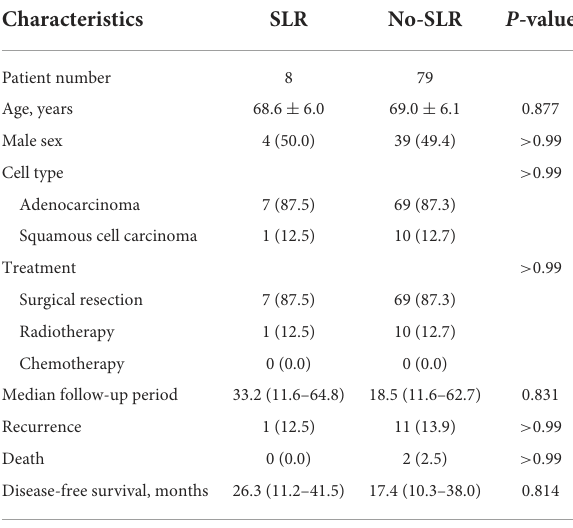
TABLE 3 Comparison of baseline characteristics and clinical courses between SLR and non-SLR groups among NSCLC